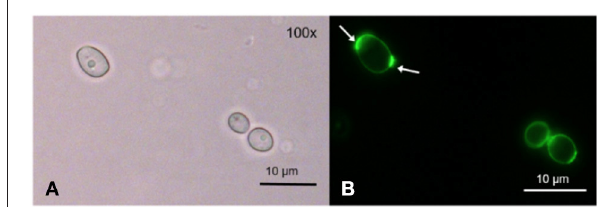
FIGURE 4 | Spatial distribution of WGA in C. albicans . C. albicans was incubated with 100 µ g/mL WGA to stain the yeast’s cell wall. WGA is marking the cell wall homogeneously at low intensity and certain areas at high intensity, most likely bud scars (shown here) and cell buds ( → ). (A) shows C. albicans cells incubated with WGA and imaged by brightfield microscopy and (B) shows the same cells imaged by fluorescence microscopy (filter: Oregon Green).